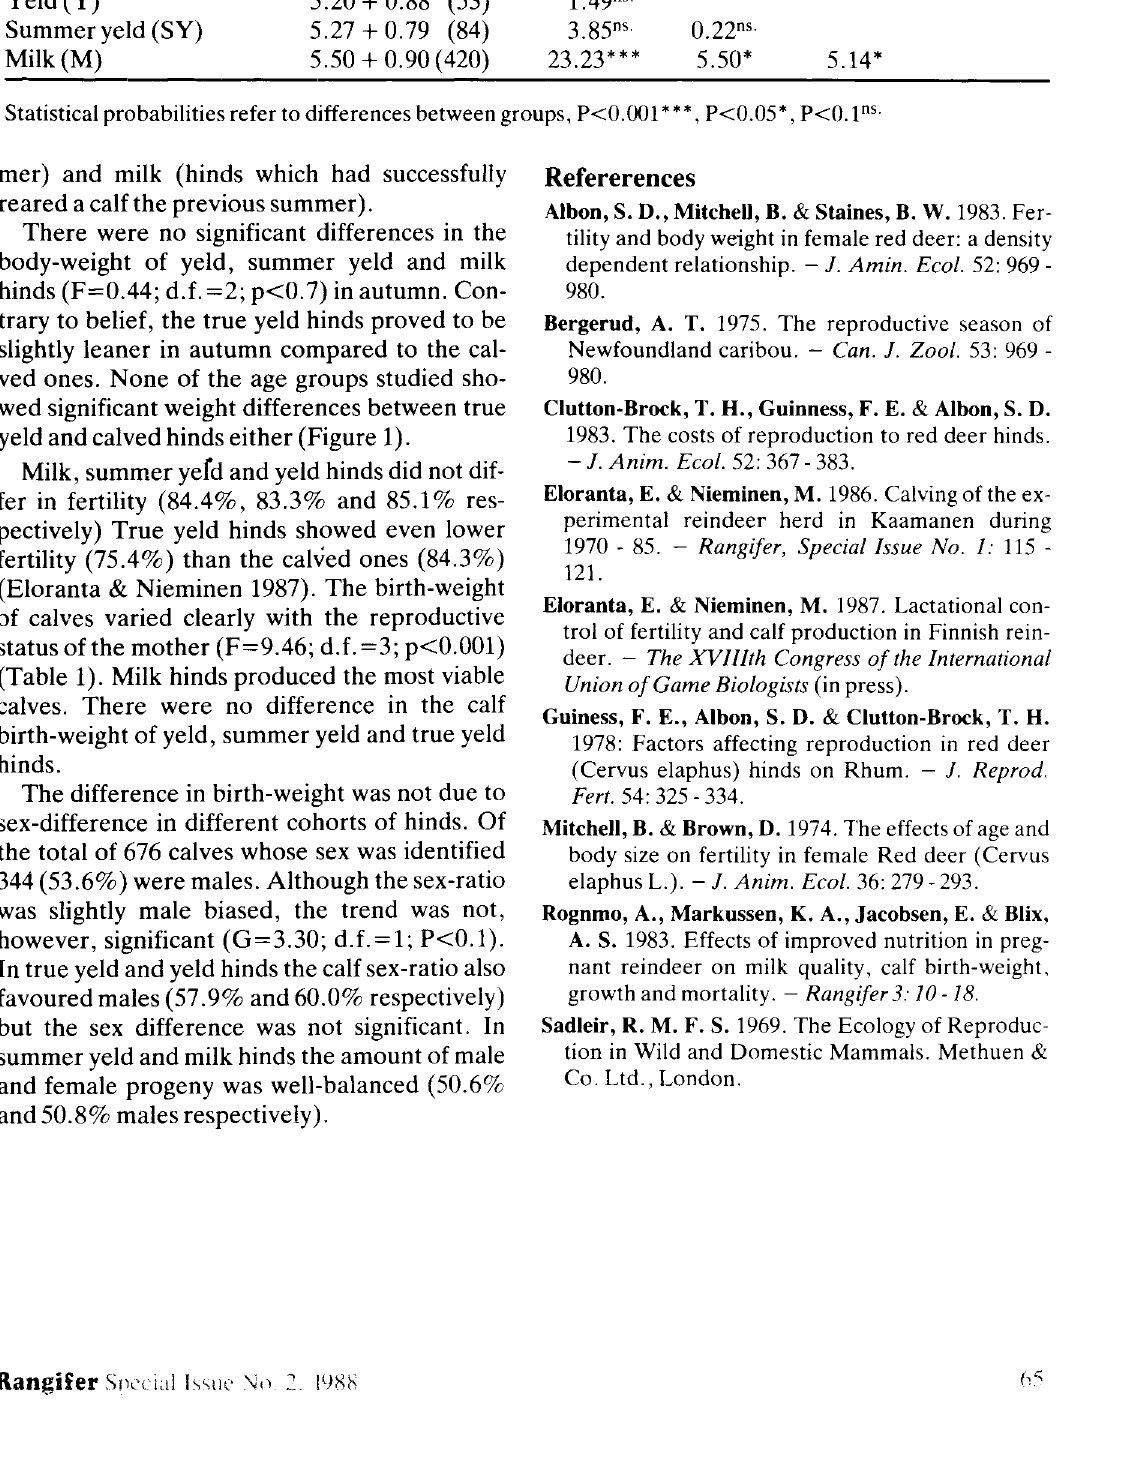
Table 1. Birth-weight of calves (x ± S.D., sample sizes shown in parenthesis) in different cohorts of hinds ac cording to their reproductive